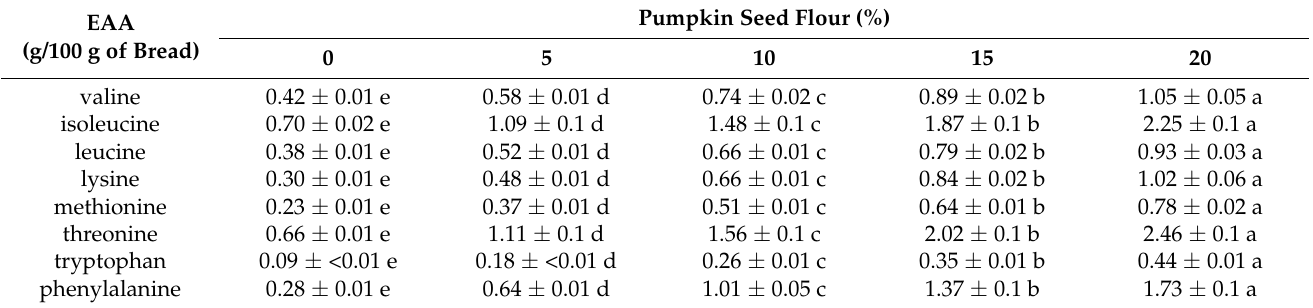
Table 4. Essential amino acid profile (EAA) of bread with the replacement of part of wheat flour with pumpkin seed flour at different percentages (0, 5, 10, 15, and 20%).